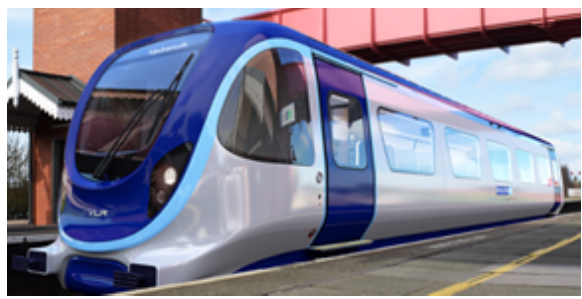
Figure 8. Revolution Very Light Rail [6].